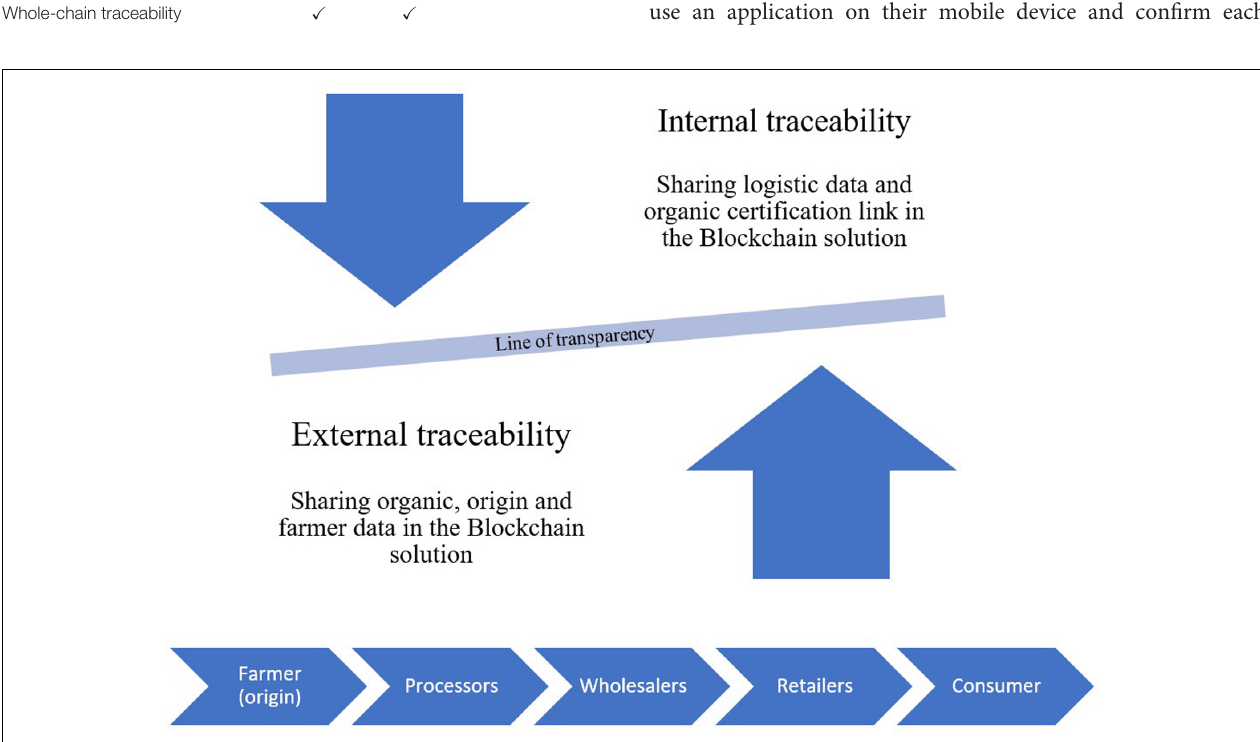
FIGURE 3 | Data sharing as the line of transparency for organic food information.